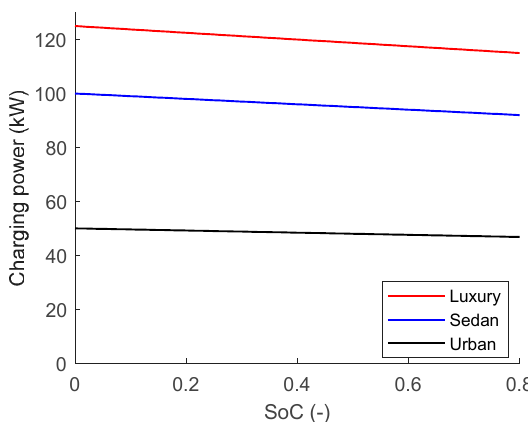
Figure 3. Charging power during quick charge for three types of vehicles.